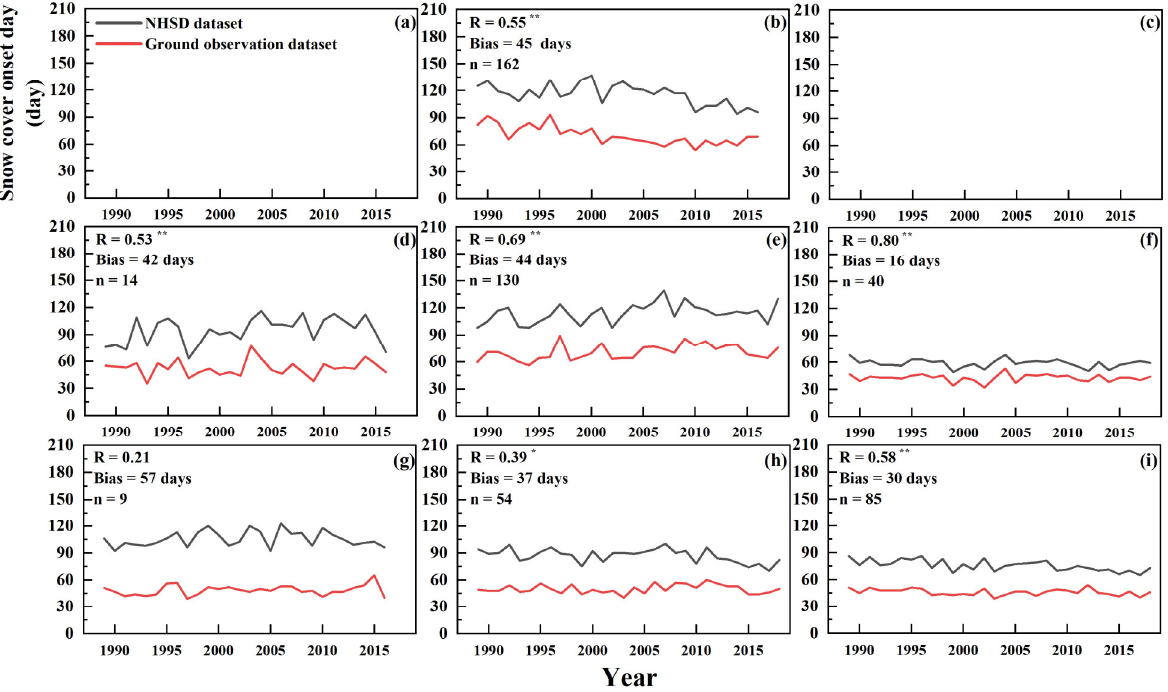
Figure 10. Comparison of the SCOD derived from NHSD and ground observation datasets in typical areas. The typical areas are ( a ) the Alps, ( b ) the Rocky Mountains, ( c ) the Qinghai–Tibet Plateau, ( d ) Alaska, ( e ) the Eastern European Plain, ( f ) the Eastern Siberian Mountains, ( g ) Northern Canada, ( h ) the West Siberian Plain, and ( i ) the Central Siberian Plateau. The vertical axis labels in panels ( b – i ) are the same as those in panel ( a ). * and ** indicate that the correlation were significant at the 95% and 99% confidence level,